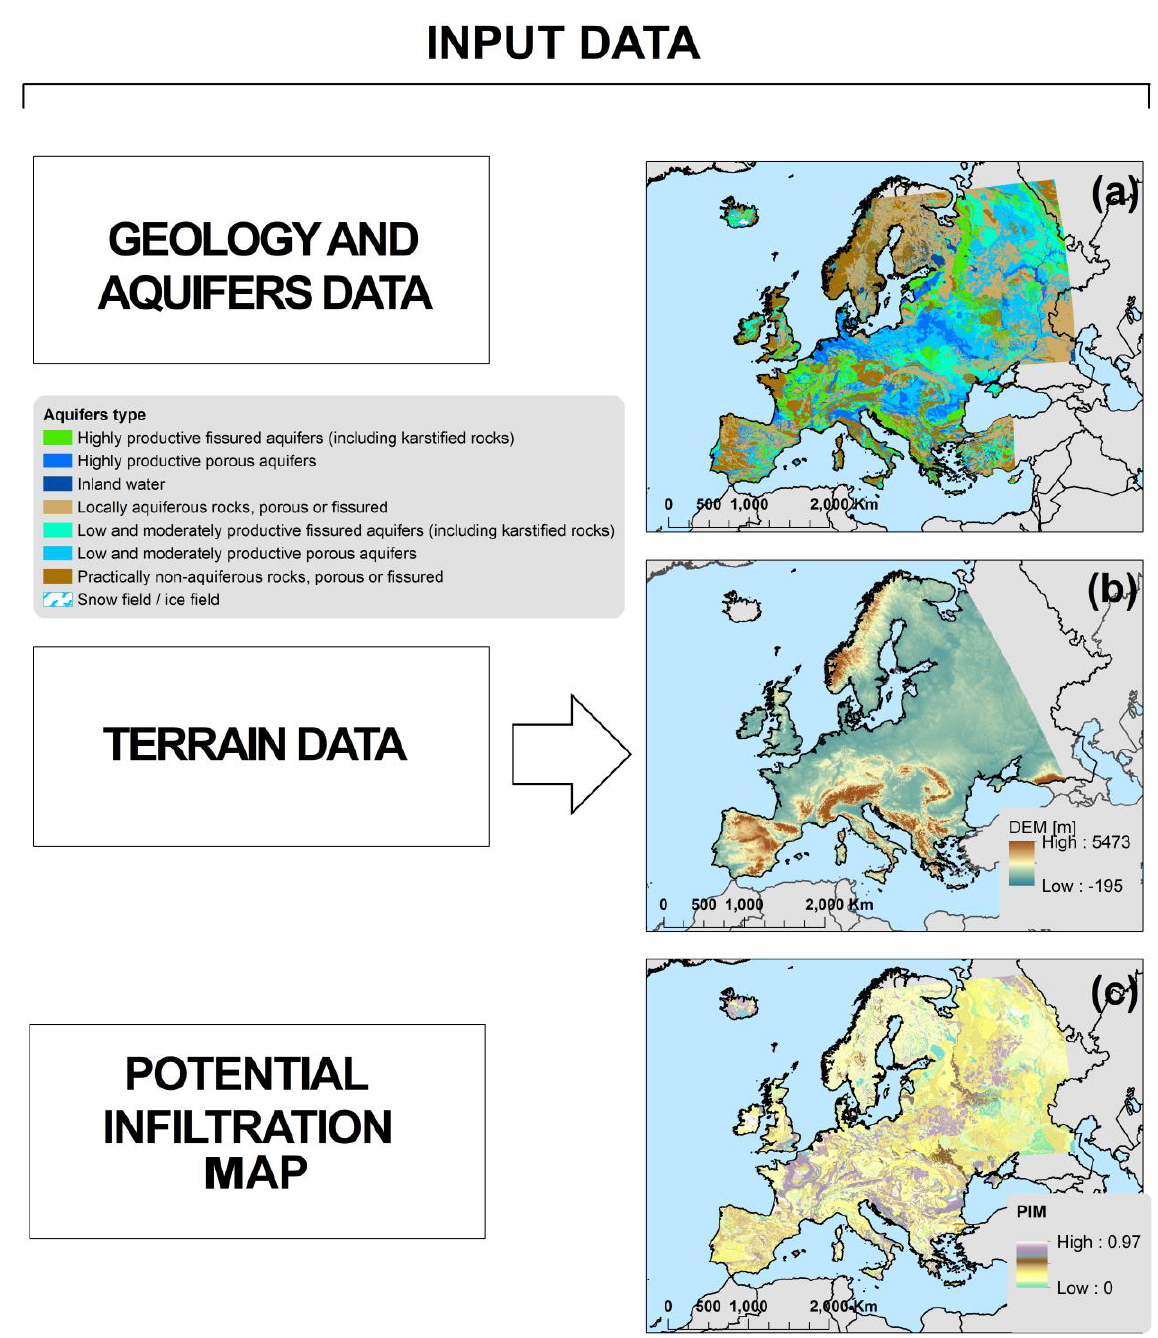
Figure 2. Framework of geology, terrain data, and potential infiltration map in Europe. ( a ) Geological formations map. ( b ) Digital elevation model. ( c ) Potential infiltration map (PIM). Note: Potential infiltration map was calculated as ratio of potential infiltration coefficient and normalization slope layer (radian